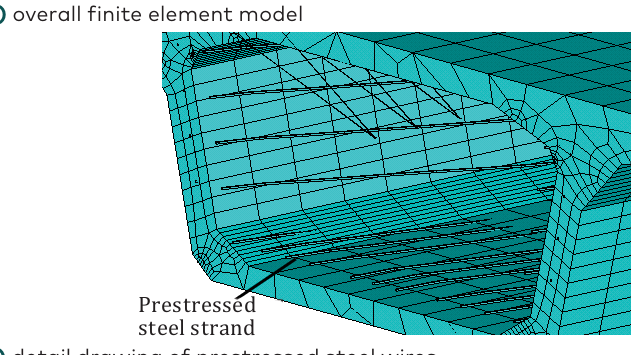
a) overall finite element